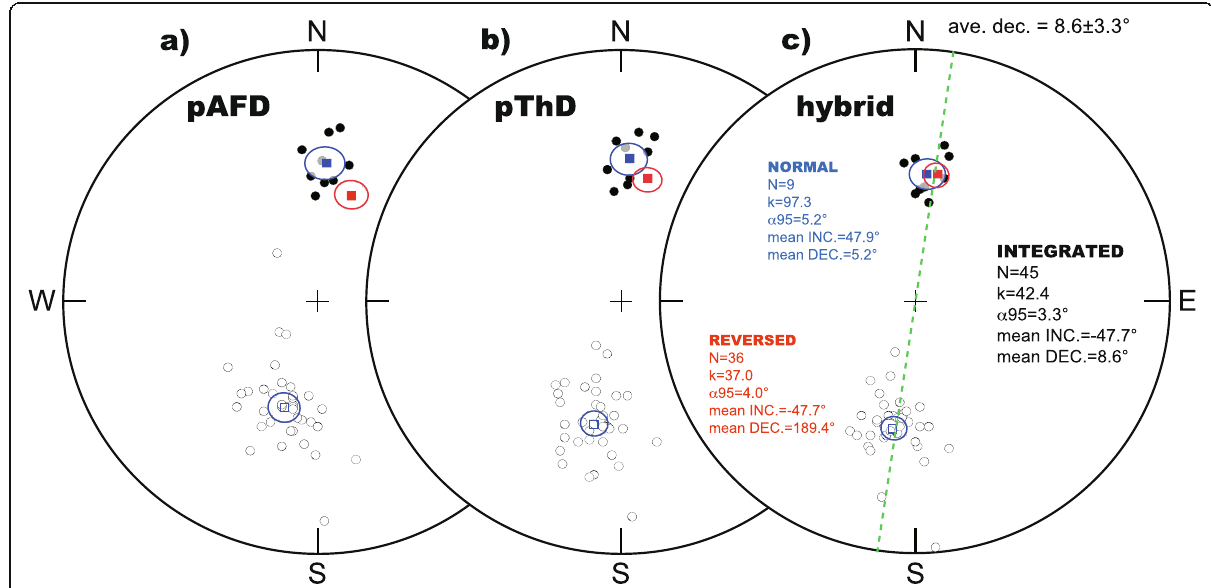
Fig. 7 Reversals test results. The equal-area stereo-net diagrams ( a – c ) show the ChRMs from the pAFD, pThD, and hybrid treatments, respectively. Closed and open circles indicate projections on the lower and upper hemispheres, respectively. The blue closed and open squares indicate the average directions of ChRMs on the lower and upper hemisphere, respectively. The blue circle indicates the 95% confidence limits ( α 95) of each average direction. The red closed square and the surrounding circle indicate the symmetric average direction and its α 95 on the lower hemisphere, which are transposed from those on the upper hemisphere in each diagram. The green dashed line on the right diagram indicates the average declination of all the ChRMs, excluding the intervals of the reversal boundaries and the lower normal polarity zone (40 – 47 m), where the RPIs indicate much lower than the average